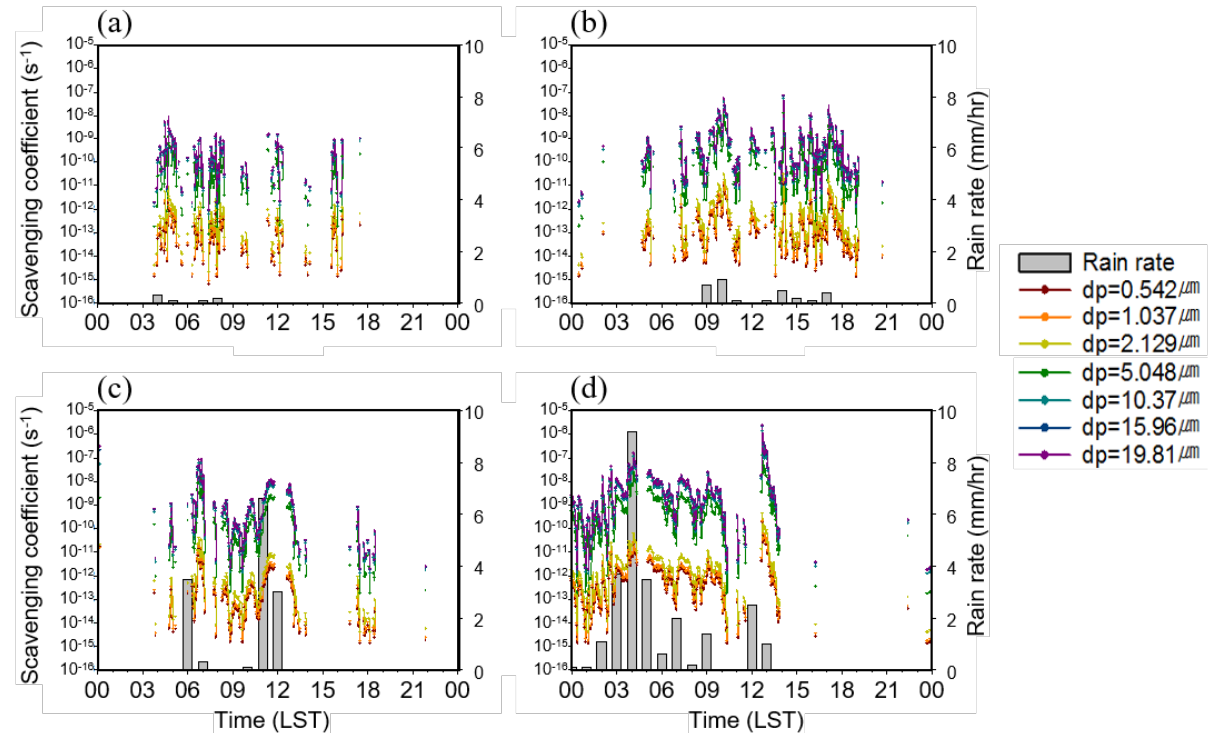
Figure 8. Time series of the scavenging coefficient and rain rate for several aerosol diameters from ( a – d ) (cases 1 to 4).